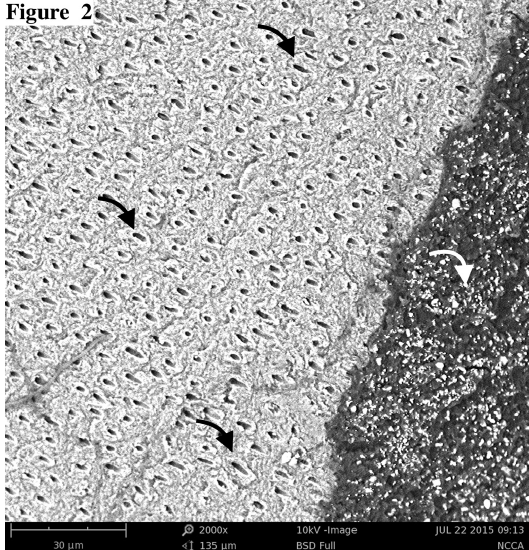
Figure 4 – (Magnification: 2000x – Scale bar: 30µm) - Representative SEM image of fractured specimen from RelyX U-100 group (dentin side). White arrow: dentin tubule with smear plug. Black arrows: dentin tubules